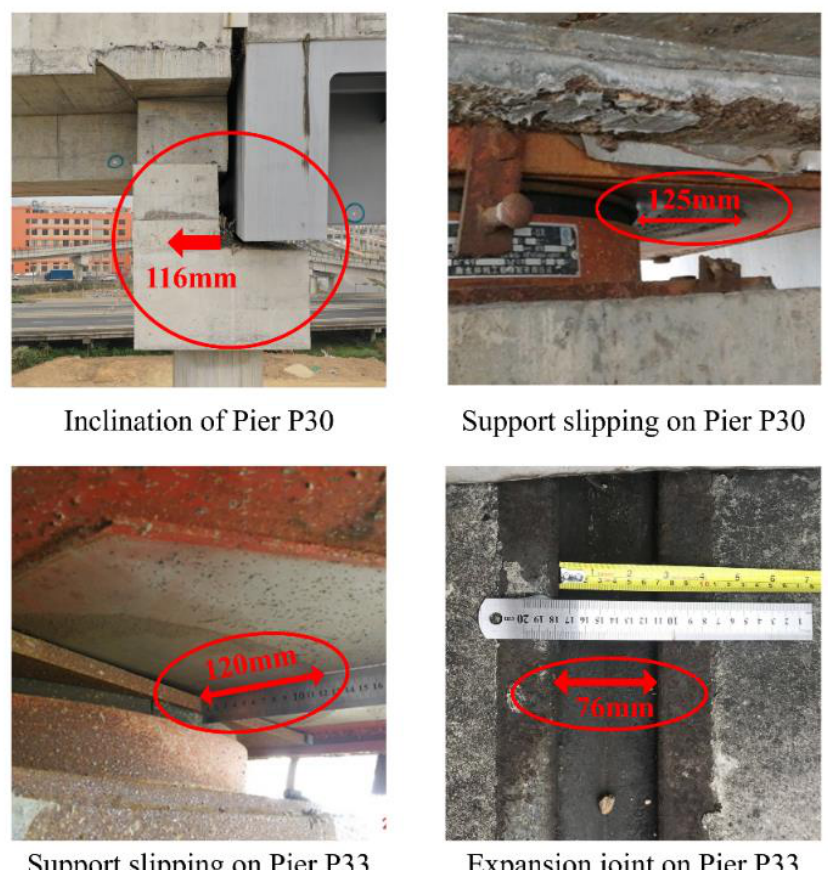
Figure 3. Disease of the ramp.